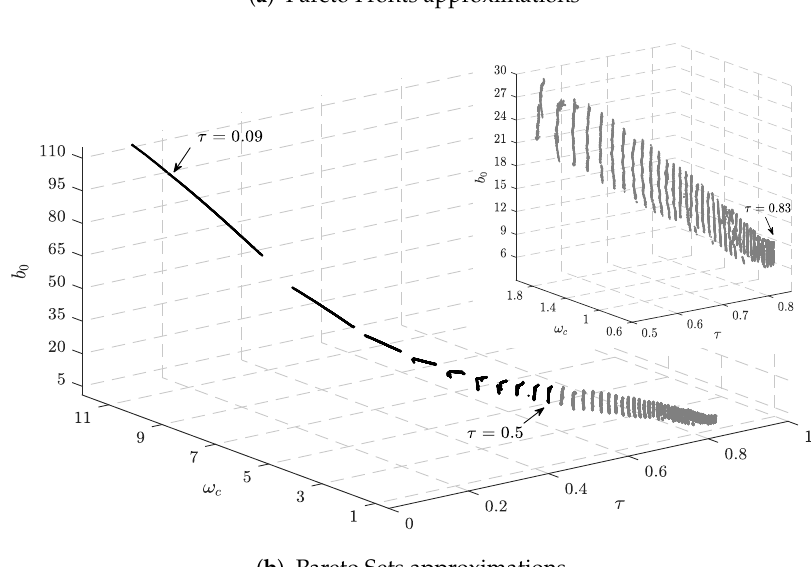
Figure 6. Results from the optimization process for the complete group of nominal plants. Pareto Sets approximations for plants with τ ≤ 0.5 (black) show that the LADRC parameters for this group have a wider range of variation and the rate of change in both parameters is greater compared to plants with τ > 0.5 (gray). An inset showing the Pareto Sets approximations for plants with τ > 0.5 is included for better